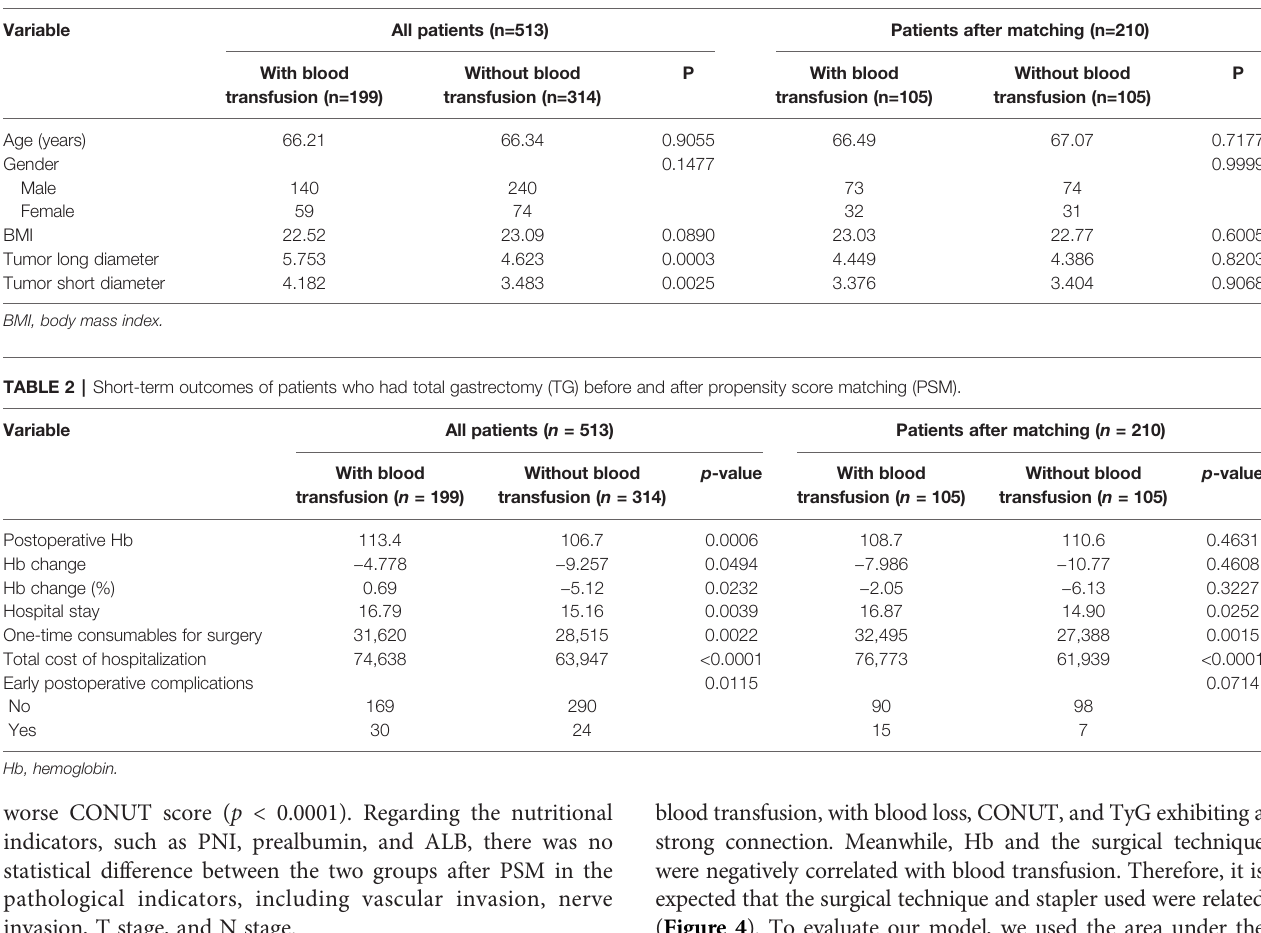
TABLE 1 | Comparison of clinical and pathological data of the patients with PSM.